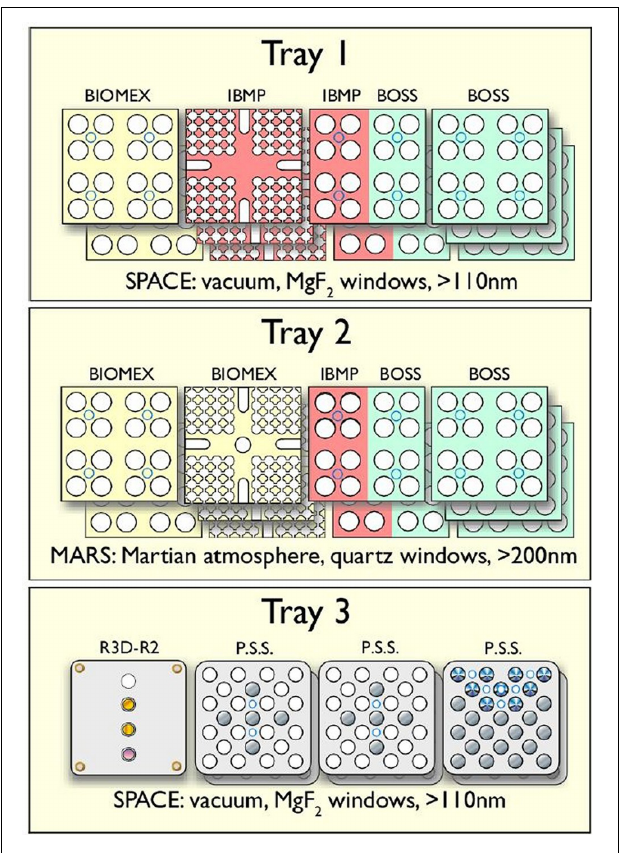
FIGURE 6 | Filter frame with integrated optical filters for trays 1 and 2. In the top left and bottom right quarters, PPO stacks covered by small round neutral density filters are integrated (brown circles). Credit: René Demets,